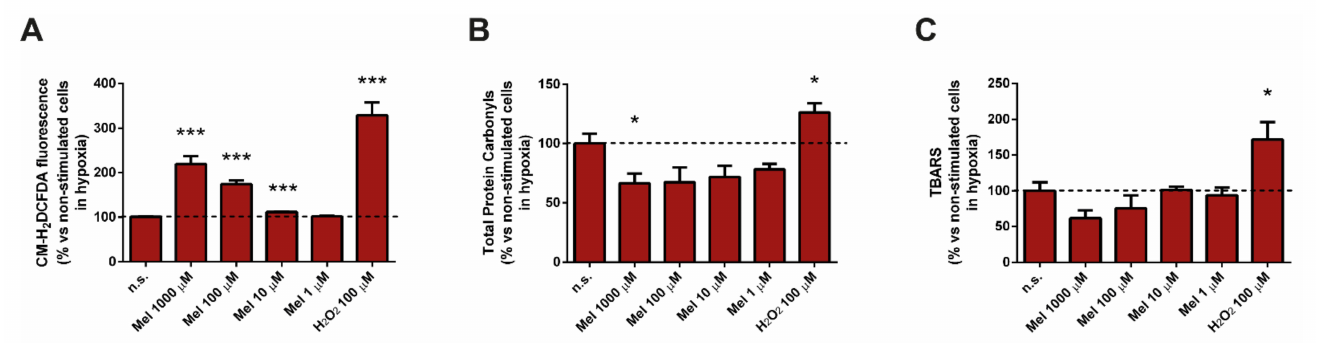
Figure 1. Effect of melatonin on the oxidative state of pancreatic stellate cells (PSC). ( A ) The cytosolic generation of reactive oxygen species (ROS) was evaluated in PSC loaded with the ROS-sensitive dye CM-H 2 DCFDA. ( B ) The effect of melatonin on the levels of protein carbonyls was studied. ( C ) The effect of melatonin on lipid-peroxidation (TBARS) was assayed. H 2 O 2 (100 µ M) was used as a control of oxidation. A horizontal dashed line represents the value observed in cells incubated under hypoxia and in the absence of melatonin (non-treated). Data are representative of three to five independent experiments (n.s., non-treated cells; Mel, melatonin; H 2 O 2 , hydrogen peroxide; *, p < 0.05; and ***, p < 0.001 vs. non-treated cells in